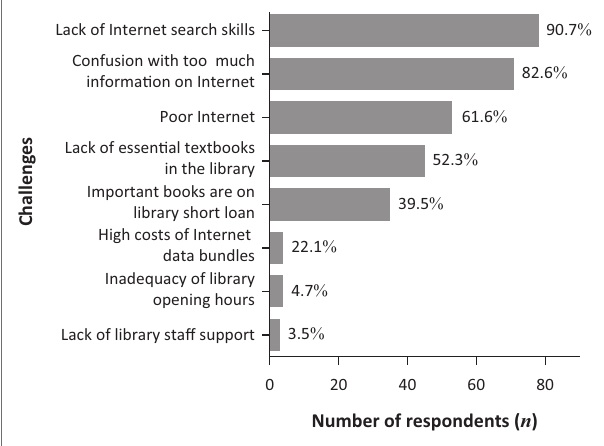
FIGURE 4: Challenges that students face in searching for